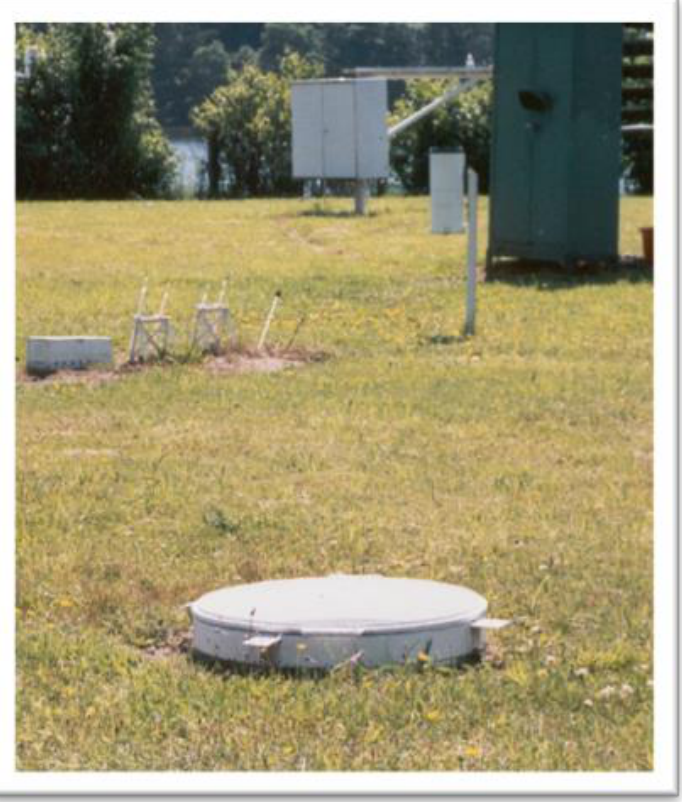
Figure 3. GGI 3000 evaporometer (foreground) at the Limnological Station in Borucino. Hellmann rain gauge can be seen in the back.